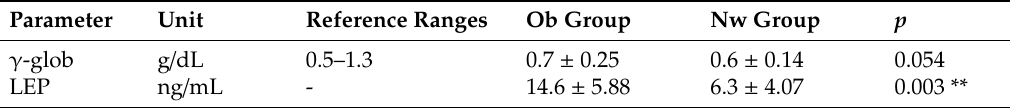
Table 5. Intensity of LEP and LEPR immunostaining in Obese and Normal-weight dog skin sections. LEP